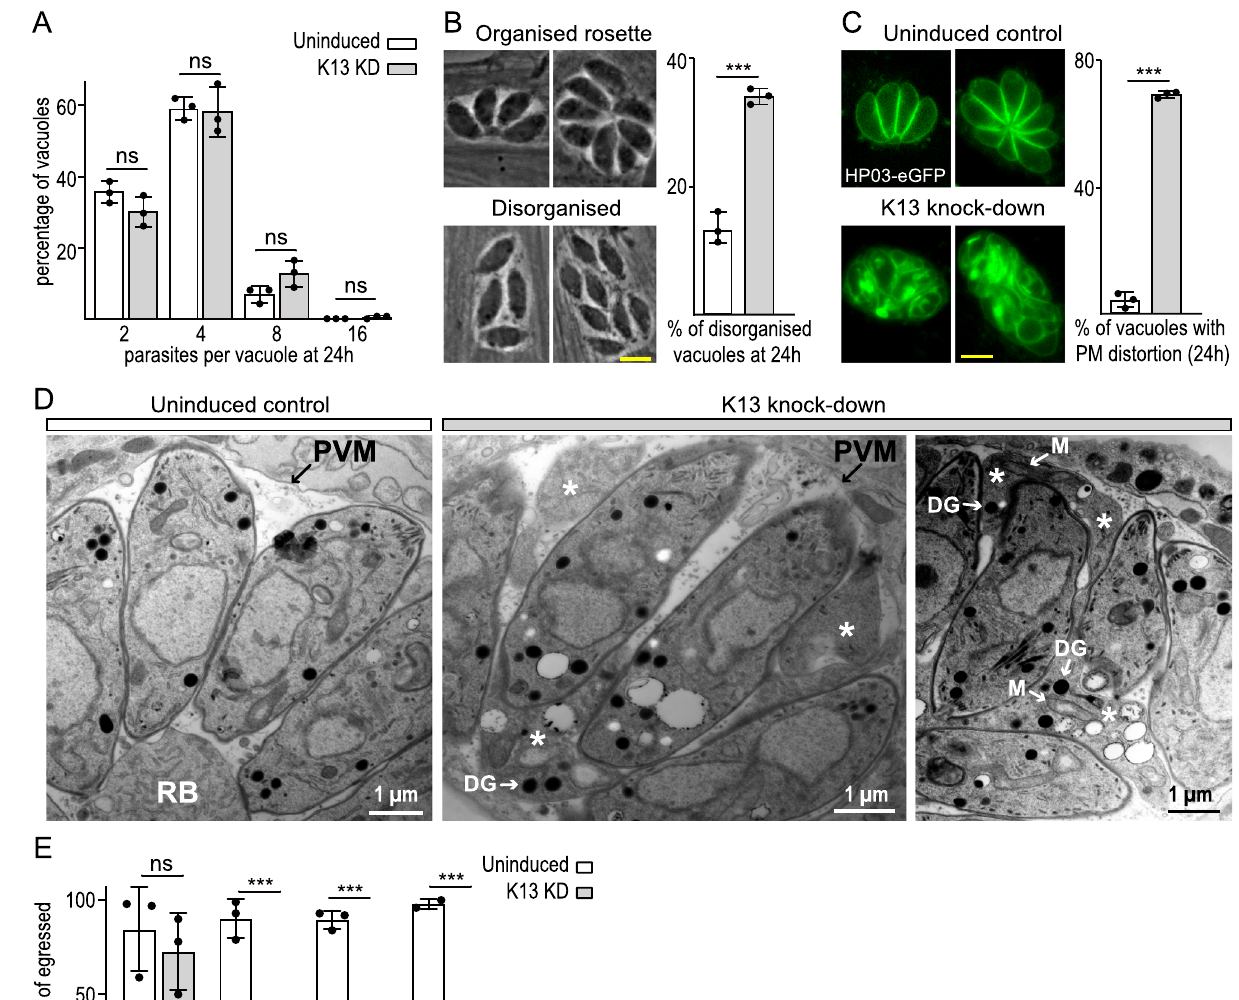
Fig. 6 | K13-depletion disrupts parasite order, integrity and egress but not replication rate. A Number of parasites per parasitophorous vacuole after 24h of post invasion replication with or without 72h of ATc-induced K13 depletion; P valuesare 0.1401(2parasites),0.8919(4parasites),0.0688(8parasites)and0.1161 (16 parasites). B Percentage of disorganized vacuoles after the same treatments as ( A ). Disordered vacuoles are scored as those that lack ≥ 75% of parasites sharing a common posterior orientation as shown by four- and eight-cell parasite rosettes (examples imaged by phase contrast); P value = 0.0002. C Live cells expressing a plasma membrane marker HP03-eGFP after the same treatments as ( A ) and ( B ) showing increasing lack of organization and PM integrity with K13-depletion (see Fig.S8formoreexamples); P value=0.00001.Thescalebarsin( B )and( C )are5 µ m. D TEM images of parasites within the parasitophorous vacuole with K13 either